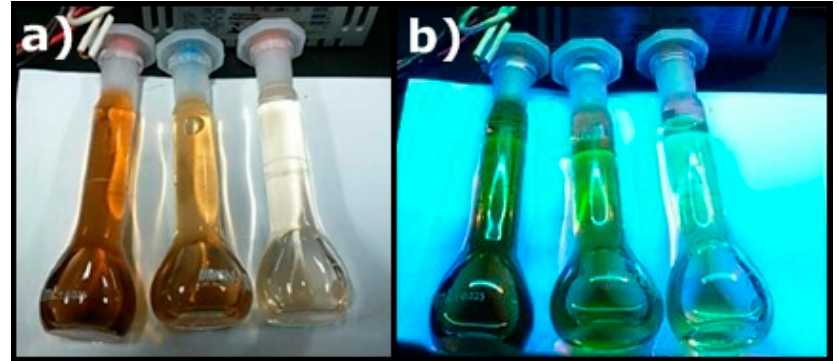
Figure 6. Humic substances produced by route I being stimulated by white light and ultraviolet light. ( a ) HSs under white light. ( b ) HSs under ultraviolet light with wavelength of 254 nm.